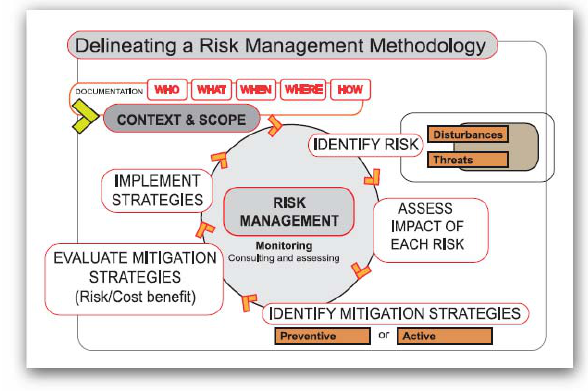
Figure 1. A risk management approach (UNESCO,